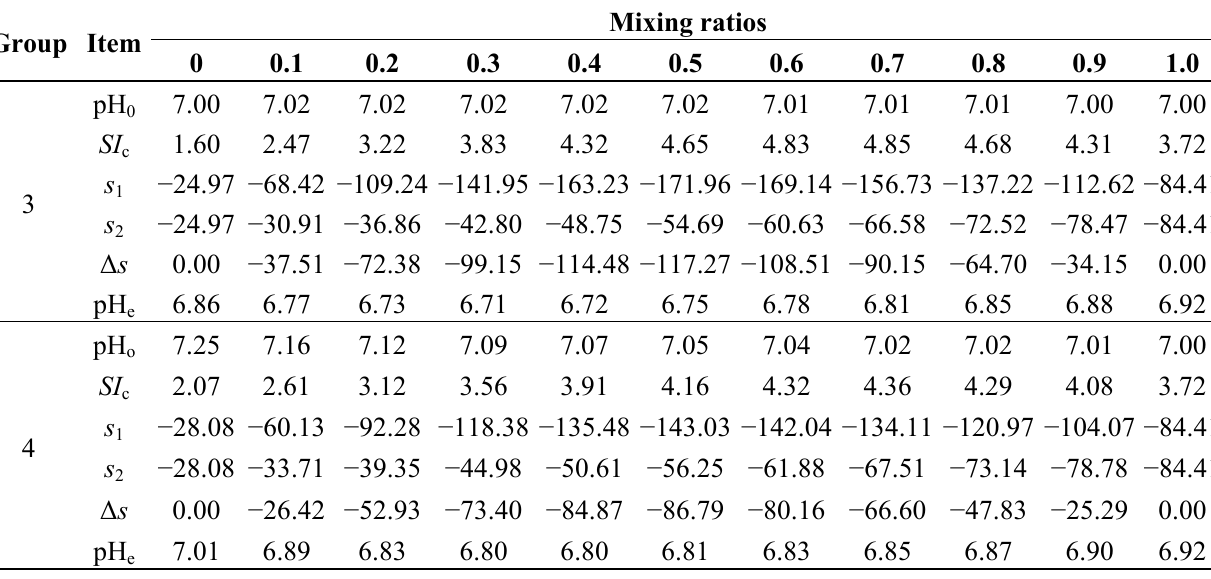
Table 4. Calculated results for mixed water from two oversaturated samples (group 3: water samples 4 and 5; group 4: water samples 4 and